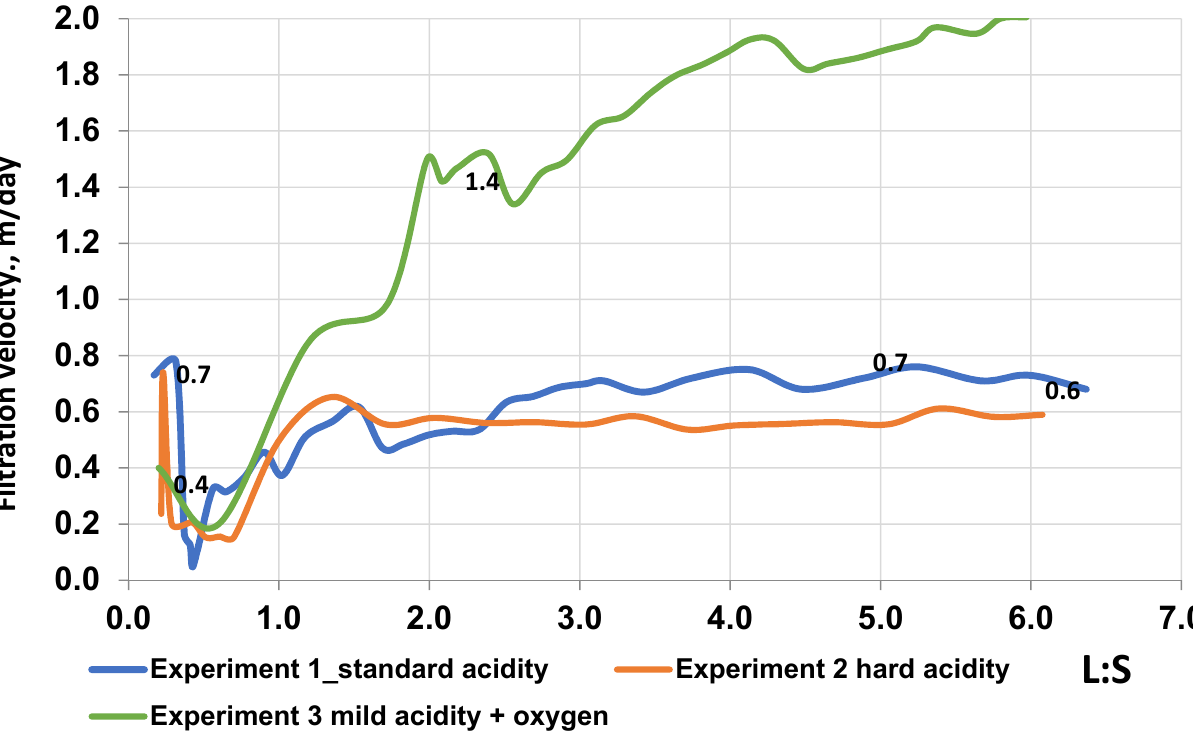
Figure 2. Dynamics of the change in the filtration rate of the solution depending on the L:S.